Question: Sum up the contents of this chart in one sentence.
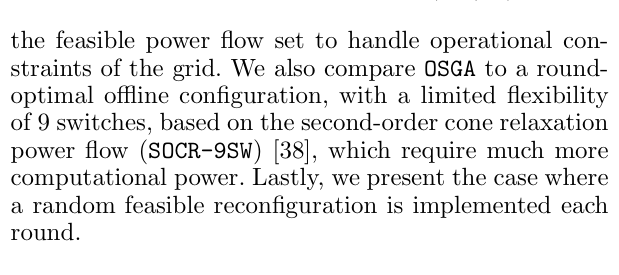
Answer: presents snapshots of the 135/8f NR at different rounds according to the apparent power demand at each node. The demand is represented by a light-dark scale: the darker the node the higher the demand is. Closed and open switches are pictured in green and red, respectively. Squares are generators. Radiality is always preserved.